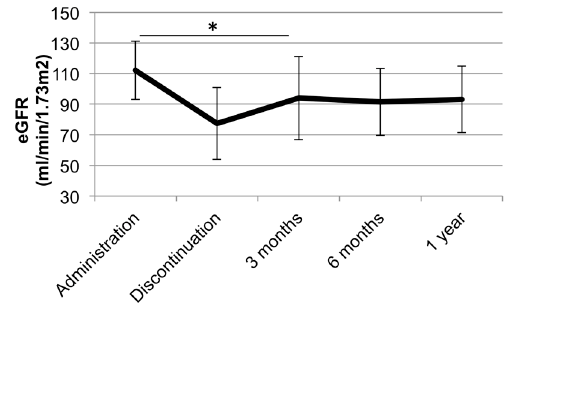
Figure 5. Changes in renal function. ( a ) Chronological changes in estimated glomerular filtration rate (eGFR) after administration of tacrolimus. ( b ) Decrease in eGFR during observation period (n = 39).